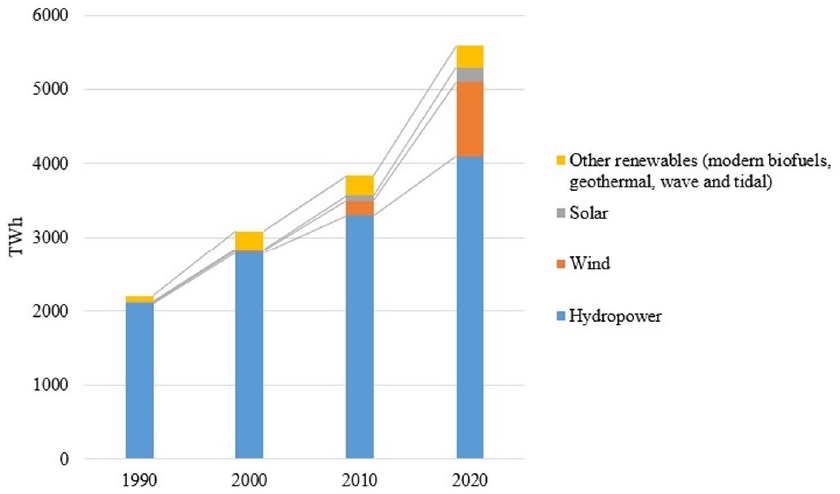
Figure 3. Modern renewable energy consumption in the world, TWh. Source: developed by the authors based on [17,18,38].*Total renewable energy consumption, measured in terawatt-hours (TWh) per year. These data include all renewable energy sources with the exclusion of traditional biomass.